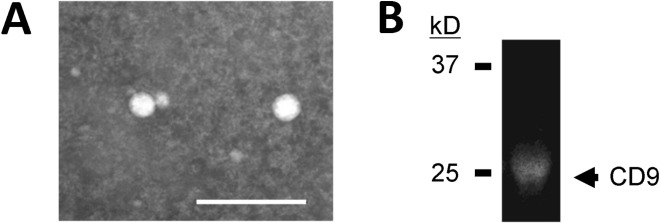
Properties of bovine plasma exosomes isolated by ultracentrifugation.(A) Representative transmission electron microscopic images of bovine plasma exosomes. The bar indicates 200 nm. (B) Detection of CD9 protein in bovine plasma exosomes by immunoblotting.